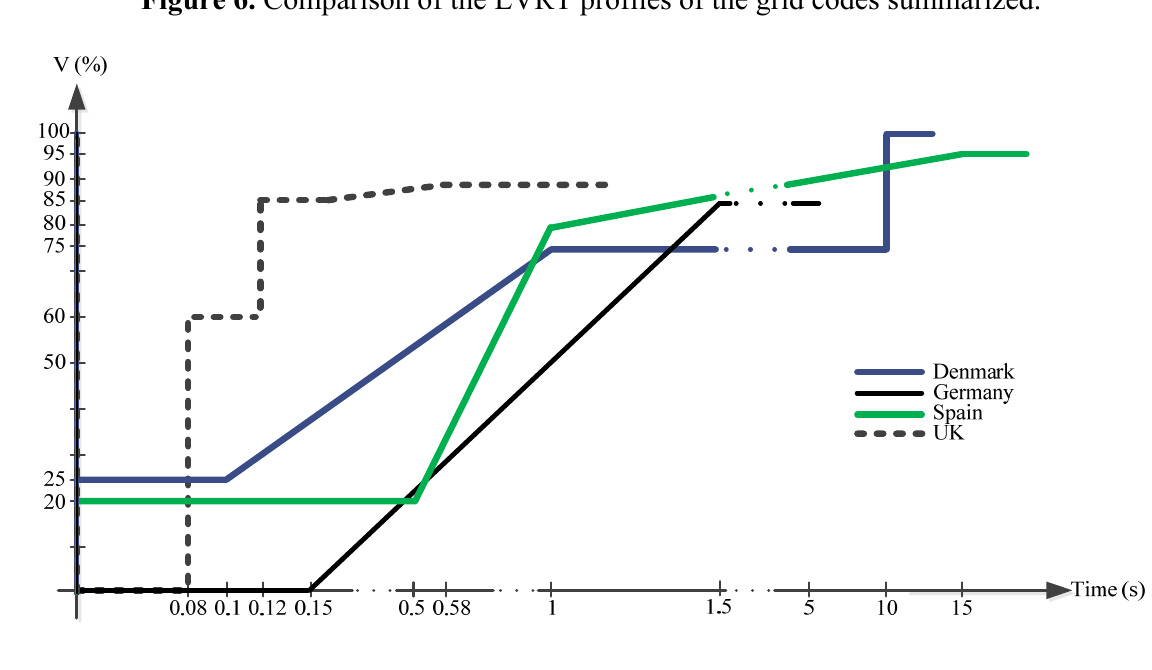
Figure 6. Comparison of the LVRT profiles of the grid codes summarized.